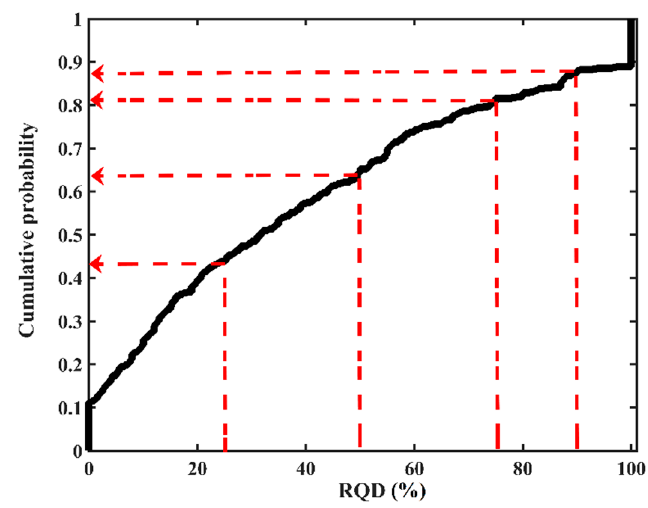
Figure 5. Cumulative distribution probability plot; the red dashed lines show the different categories according to the rock mass quality.